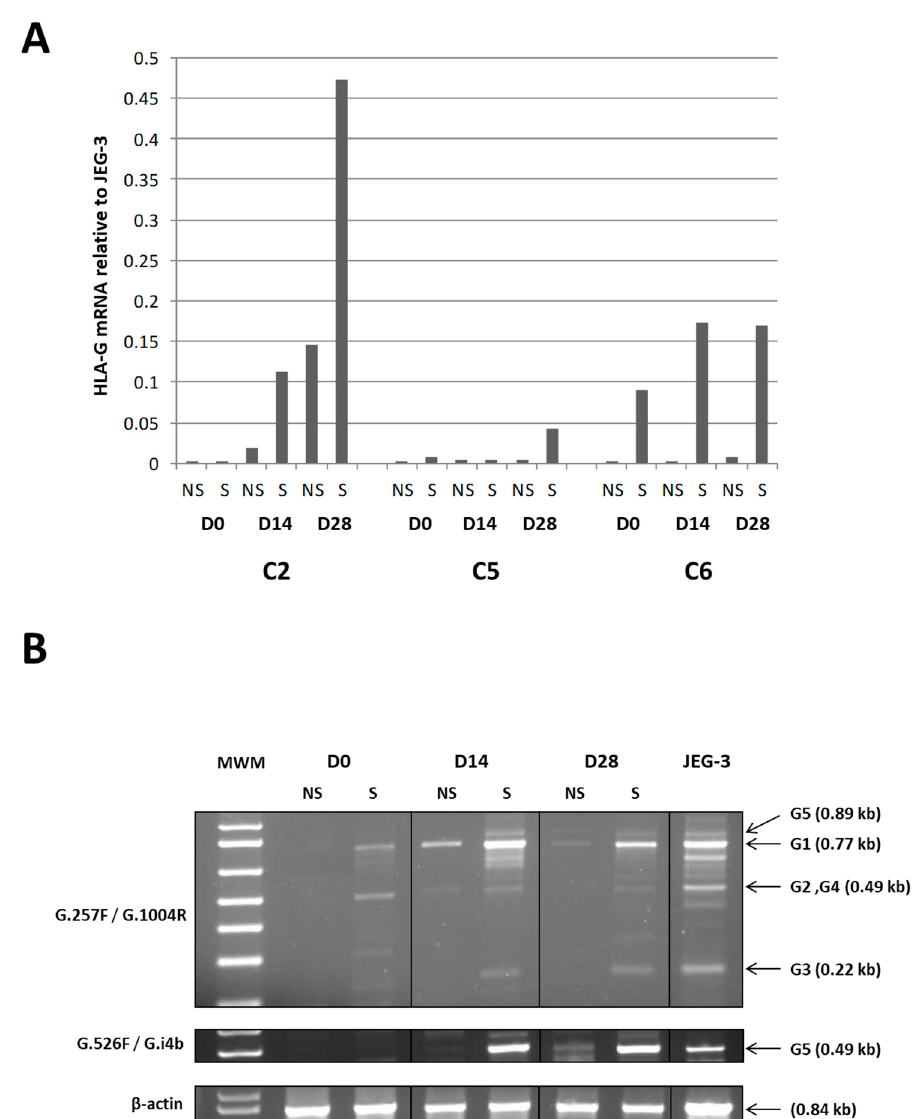
Figure 9. Real-time RT-PCR analysis. ( A ) showing relative quantities of HLA-G transcripts in WJ-MSC from three umbilical cords (C2, C5, C6) at the end of the cell expansion, Day 0 (D0), and on Day 14 (D14) and Day 28 (D28) during chondrogenic di ff erentiation in Alg / HA hydrogel, in the absence (NS) or presence (S) of Interferon γ (IFN- γ ) and Tumor Necrosis Factor α (TNF- α ). The amount of HLA-G transcripts in JEG-3 cells was assigned a value of 1. No variation of GAPDH mRNA levels were observed considering the conditions used and chondrogenic di ff erentiation. Representative standard RT-PCR analysis ( B ) was performed with the C6 umbilical cord on D0, D14, and D28, and JEG-3 cells targeting least alternative transcripts HLA-G1,-G2,-G3 / G4 and G5 with primer set G.257F / G.1004R and HLA-G5 alone with primer set G.526F / G.i4b. β -actin amplification was used as internal control. MWM—molecular weight marker; NS and S-WJ-MSCs not stimulated or stimulated, respectively, with IFN- γ and TNF- α . PCR products obtained with each primer set were collected from the same agarose gel to assemble the picture.